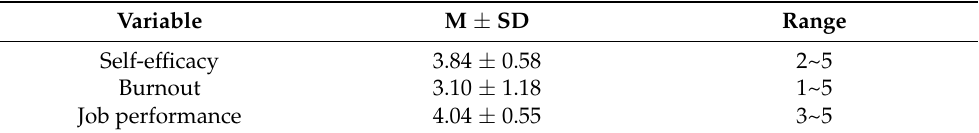
Table 2. Mean scores for self-efficacy, burnout, and job performance ( n =